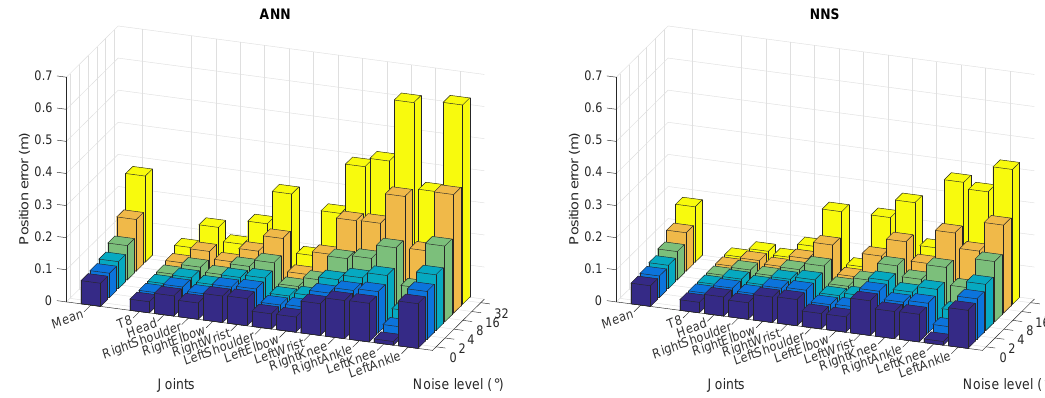
Figure 12. Mean (over all six subjects) joint position error obtained with ANN and NNS when a Gaussian white noise signal was applied to the heading orientation of the inputs. The magnitude of this rotation noise (standard deviation of the Gaussian white signal) is shown on the x-axis.